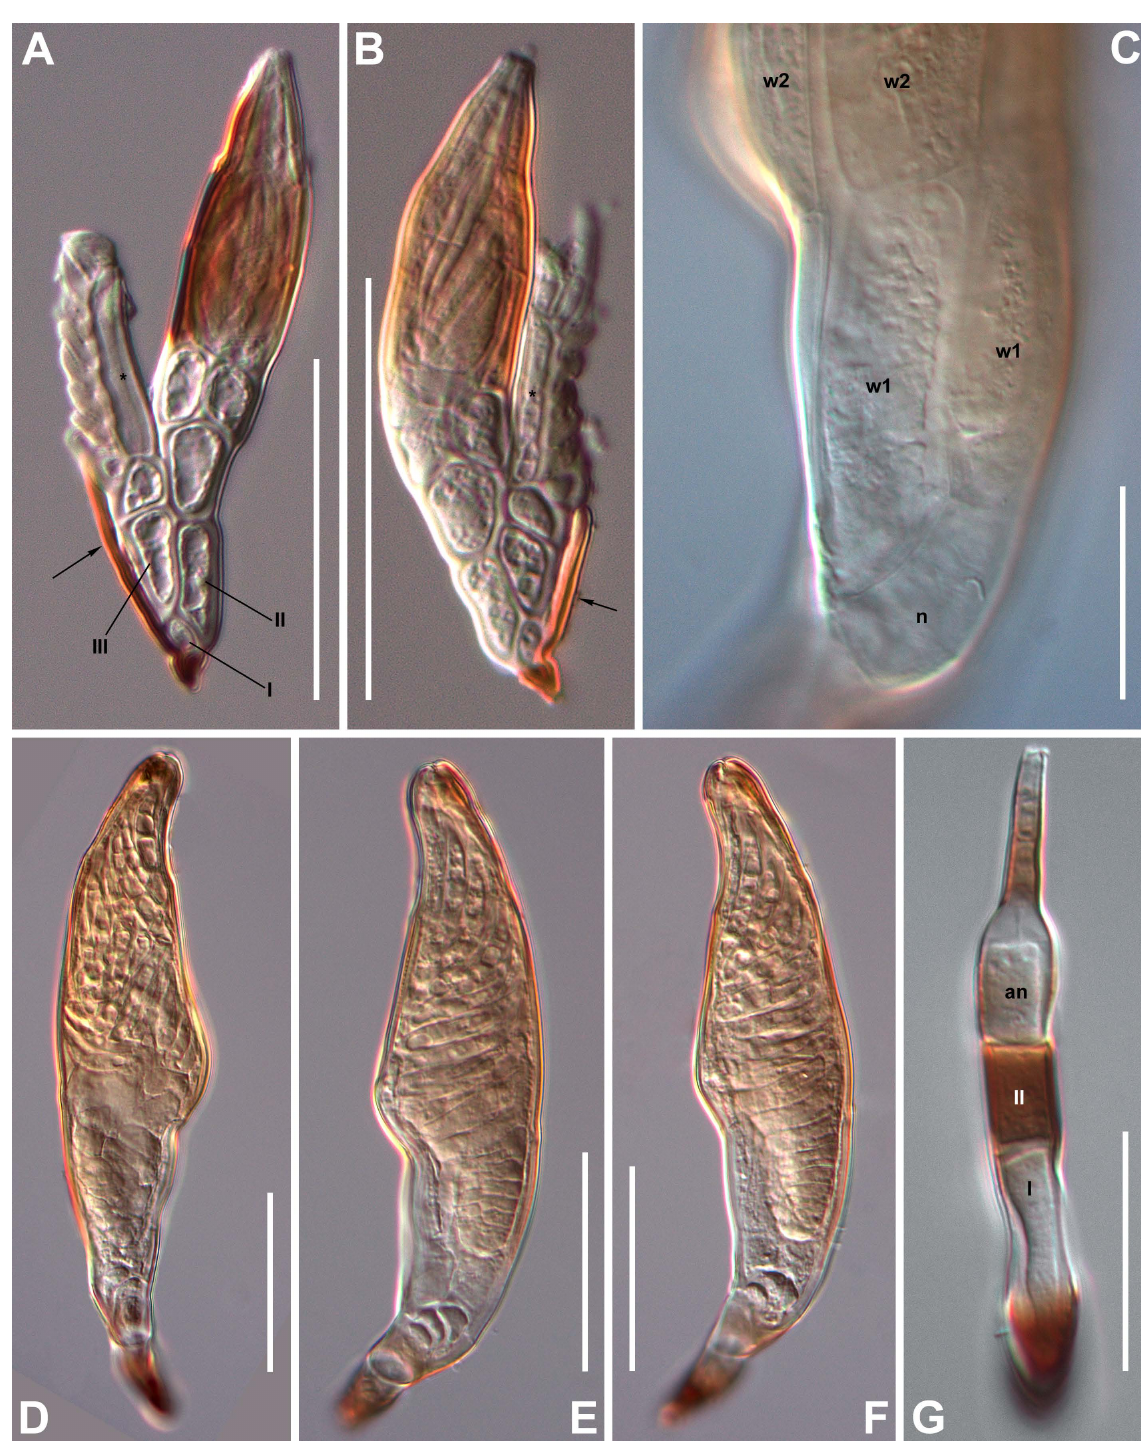
Fig. 65. A – B . Tavaresiella hebri T.Majewski. Two mature thalli with labelled I, II, III cells, elongated main cell of inner appendage branch (*), and darkened projection from cell I (arrows). – C – G . Amorphomyces ventricosus Santam. sp. nov. C . Lower area of perithecium in detail to focus on cells n and some of the wall cells (w ). D – F . Female mature thalli. G . Male thallus with labelled cells I, II and antheridium (an). n Scale bars: A–B, D–F = 50 µm; C, G = 25 µm. Photographs from slides ZMUC C-F-124090 (A–B), ZMUC C-F-123457 (D–G)